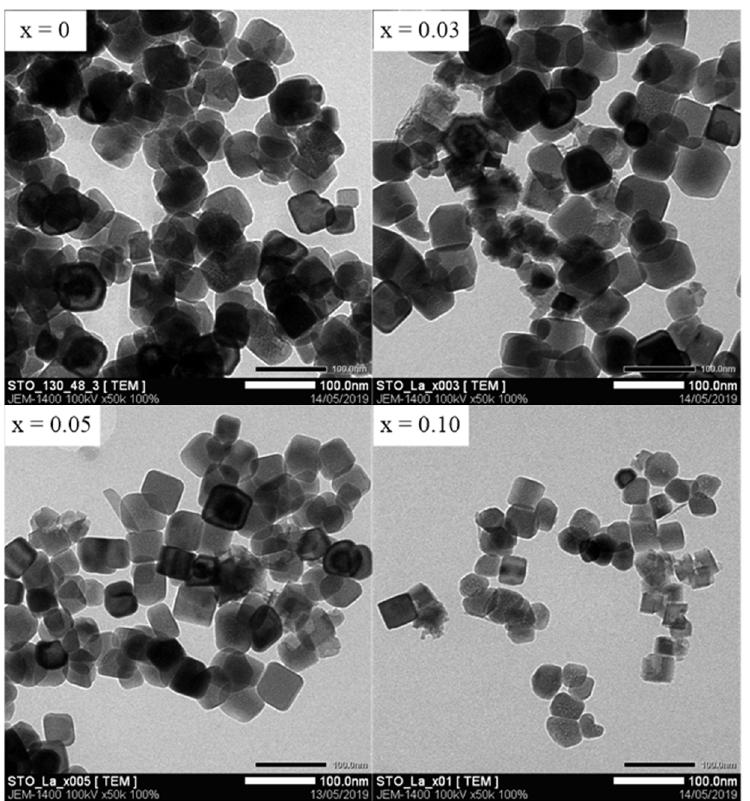
Figure 4. TEM images of Sr 1 − x La x TiO 3 samples with the optional doping rate (x = 0, 0.03, 0.05, 0.1).